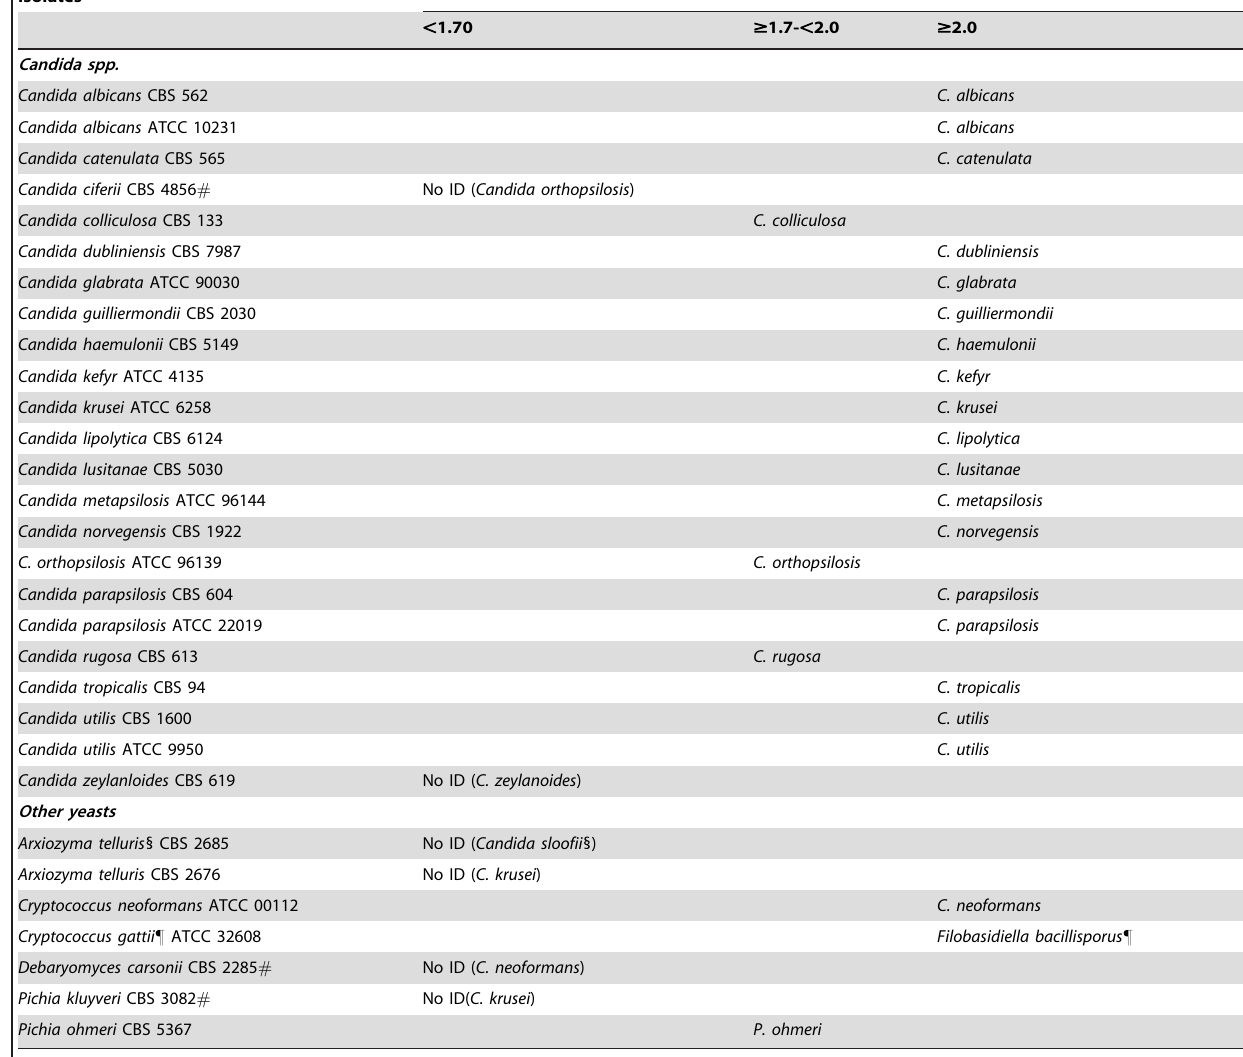
Isolates MALDI-TOF Identification according to Bruker Score